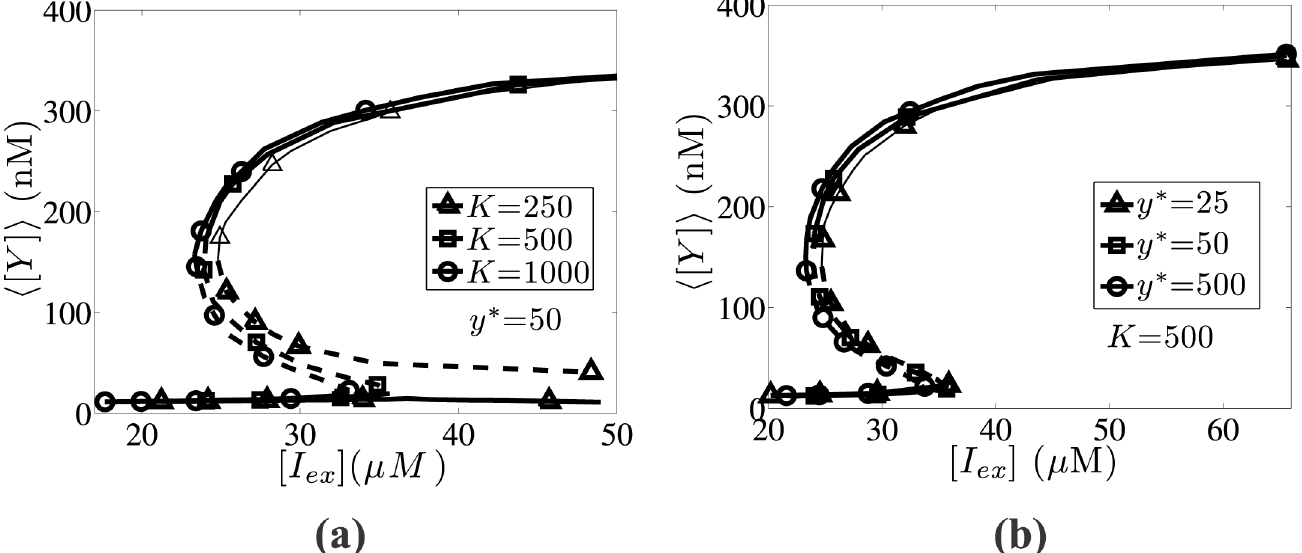
Fig 8. Effect of operator fluctuations, K , and reference number of molecules, y * . Effect of different sources of intrinsic heterogeneity on the average expression, h [ Y ] i , as a function of the external IPTG concentration, [ I ex ]: (a) Effect of parameter K : lines with open circles correspond to K = 1000, lines with open squares correspond to K = 500 and lines with open triangles correspond to K = 250. (b) Effect of parameter y * : lines with open circles correspond to y * = 500, lines with open squares correspond to y * = 50 and lines with open triangles correspond to y * = 25. In both figures, solid and dashed lines denote stable and unstable steady state solutions, respectively. Parameter set values: f = 0.5, m = 2, π = 0.03 and κ = 0.05.